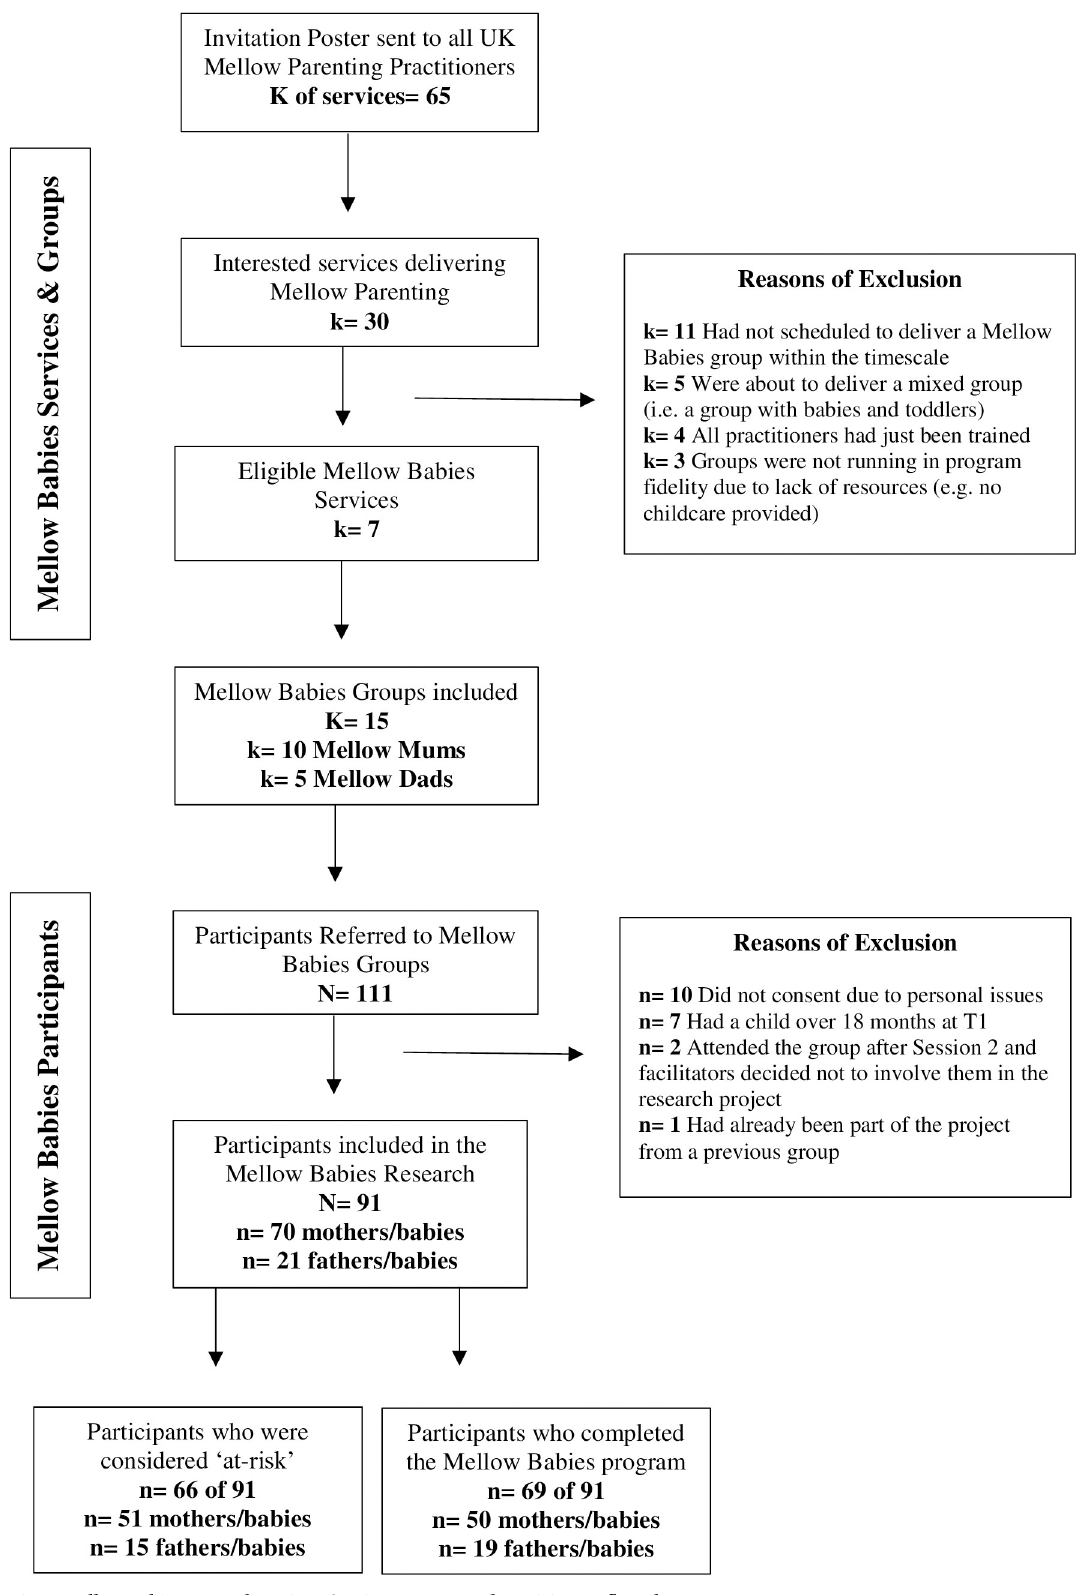
Fig 1. Mellow Babies research project: Services, groups and participants flow